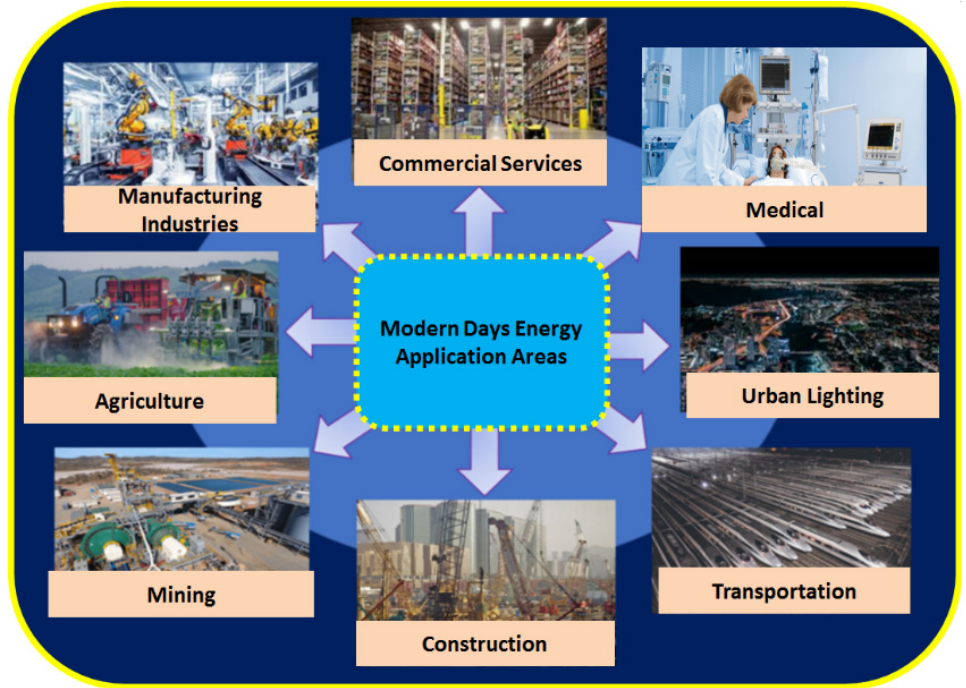
Figure 1. A glimpse of the key modern human civilization application areas where energy is one of the most important elements. the most important